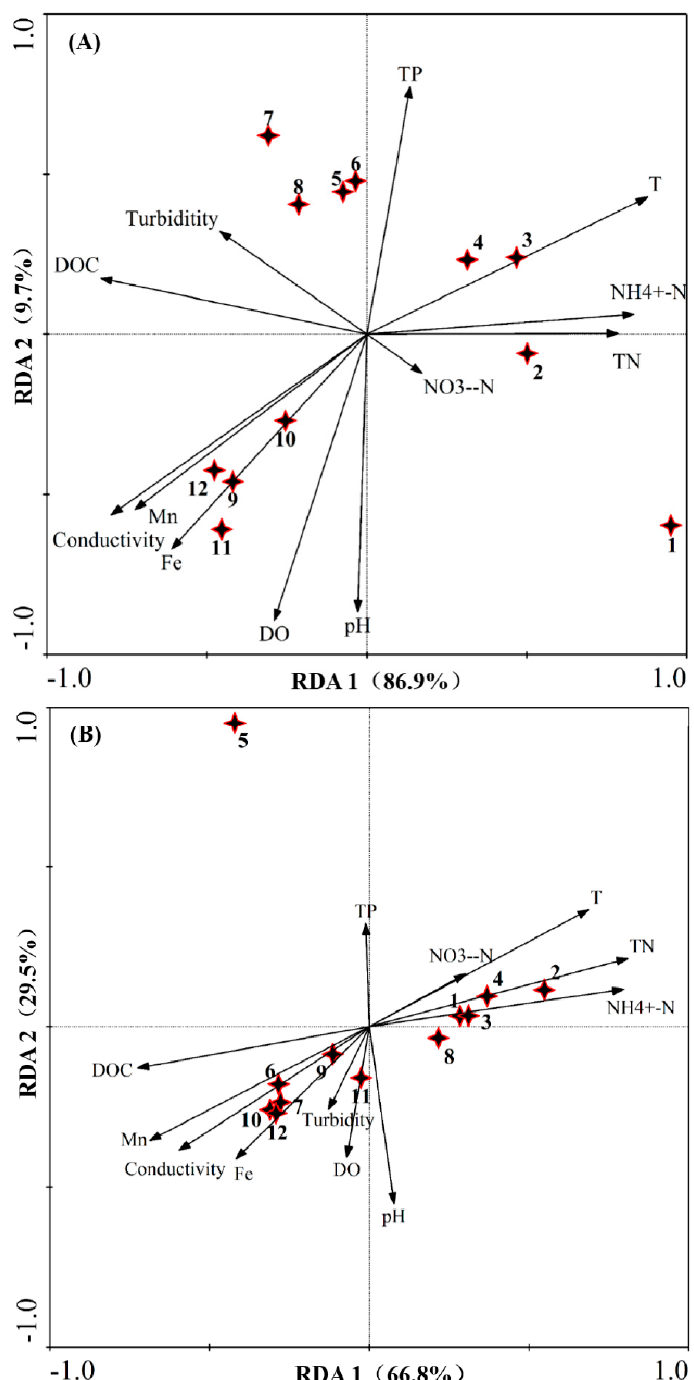
Figure 11. Redundancy analysis (RDA) of algal ( A ) and eukaryotic ( B ) communities in Jinpen reservoir from October to December 2018. Stars represent sampling points and 1,2, 3, 4, 5, 6, 7, 8, 9, 10, 11, and 12 represent Oct.—0 m, Oct.—2 m, Oct.—5 m, Oct.—10 m, Nov.—0 m, Nov.—2 m, Nov.—5 m, Nov.—10 m, Dec.—0 m, Dec.—2 m, Dec.—5 m, and Dec.—10 m, respectively. For the algal community, RDA1 explains 86.9%, and RDA2 explains 9.7% of the total variance. For the eukaryotic community, RDA1 explains 66.8%, and RDA 2 explains 29.5% of the total variance. The primary factors for the variables of the water quality data are represented by arrows. DO = dissolved oxygen; TN = total nitrogen; TP = total phosphorus; DOC = dissolved organic